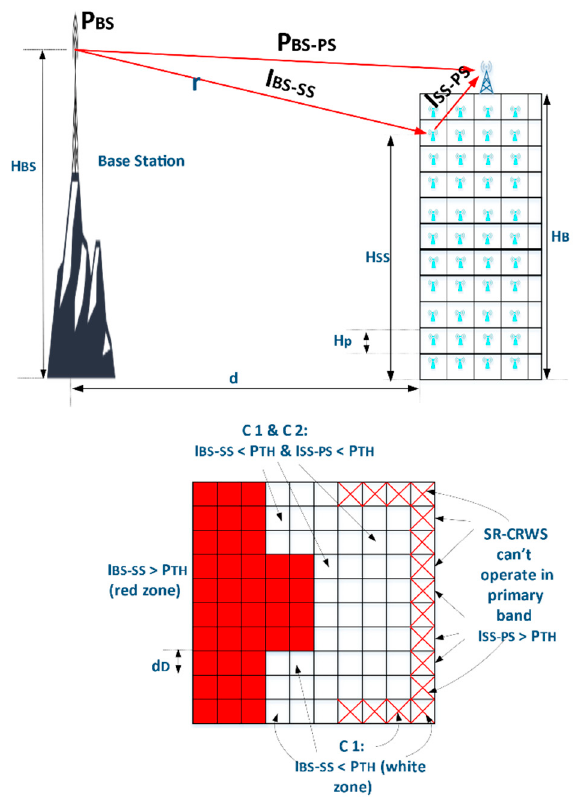
Figure 2. Description of the scenario for the parameters, interference conditions, and ESA per floor.